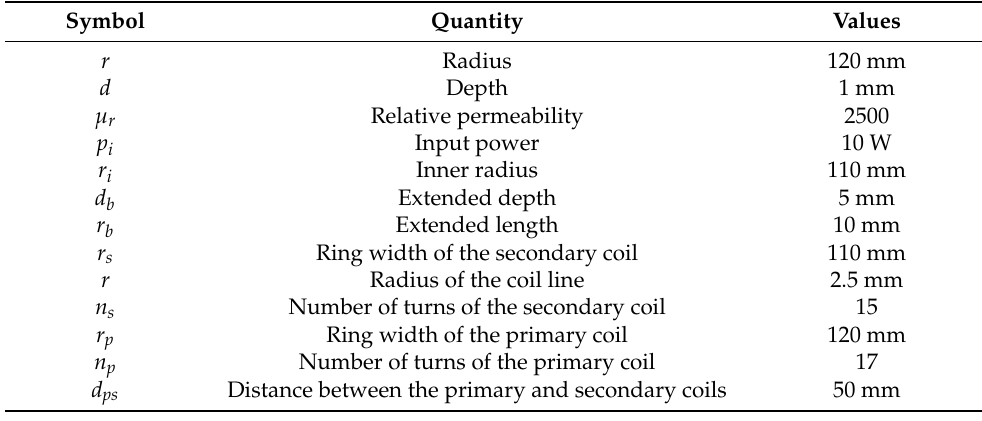
Table 4. Main coupler parameters with the proposed structure shield.